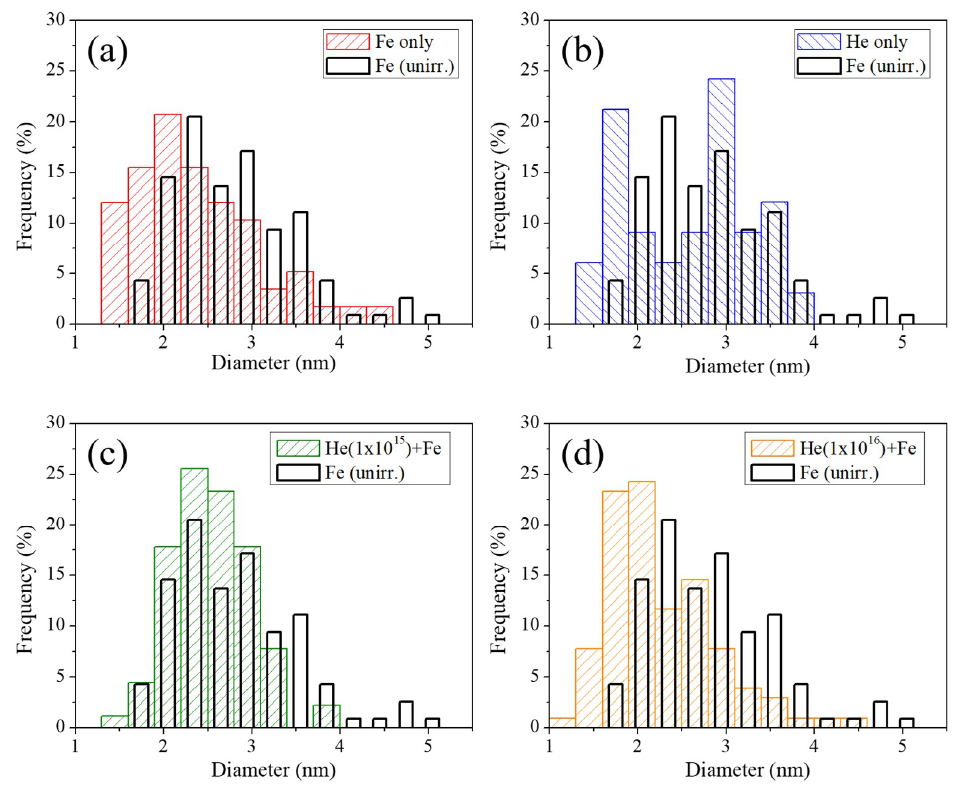
Figure 11. Dispersoid size distributions of ( a ) Fe irradiated, ( b ) He implanted-only, ( c ) He (1 × 10 15 ) + Fe, and ( d ) He (1 × 10 16 ) + Fe irradiated samples from the 350 nm depth. Black lines superimposed on each figure are the dispersoid size distribution at 2000 nm depth of Fe irradiated specimen.